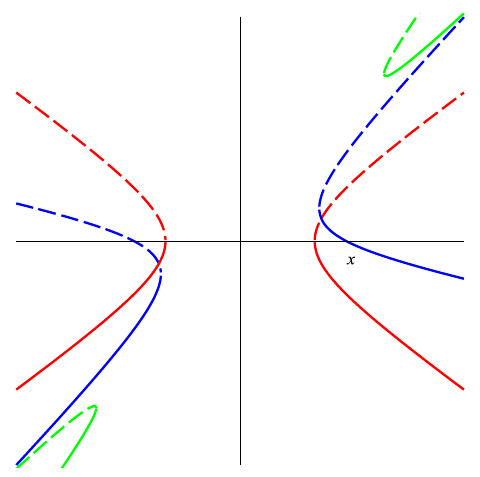
Figure 9. The fermi surface pro(cid:12)les for ! 0 < ! 1